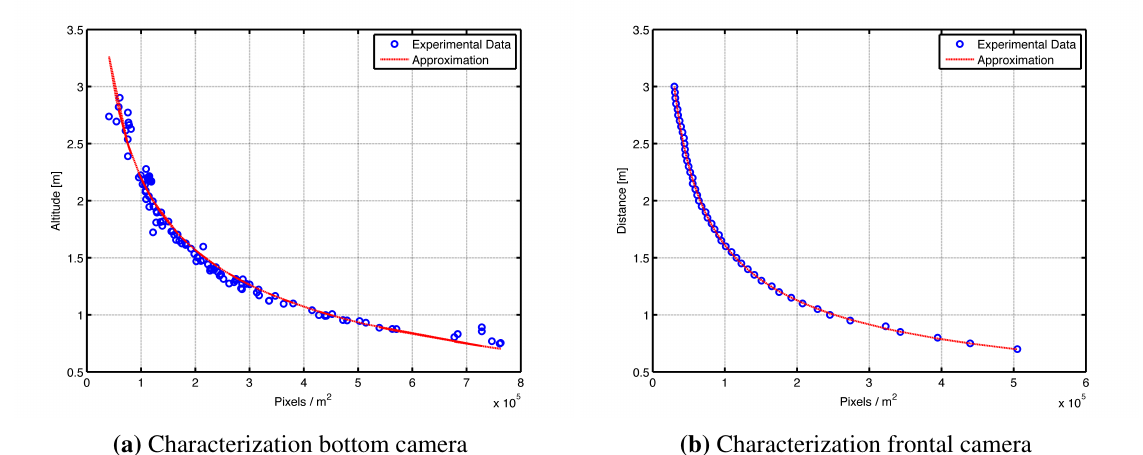
Figure 3. Camera characterization. Experimental data and approximation obtained for the ( a ) bottom and ( b ) frontal